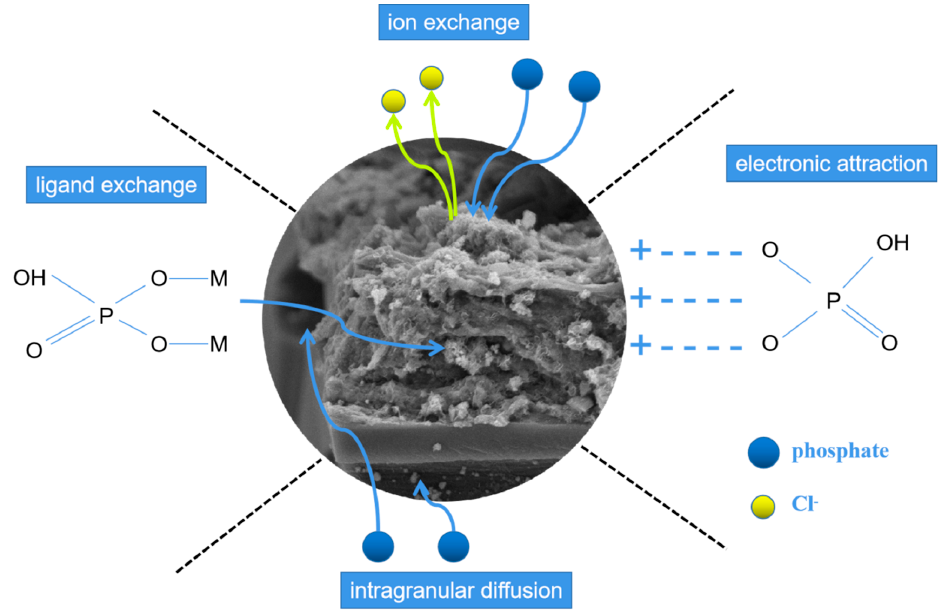
Figure 12. Possible mechanisms of phosphate adsorption.